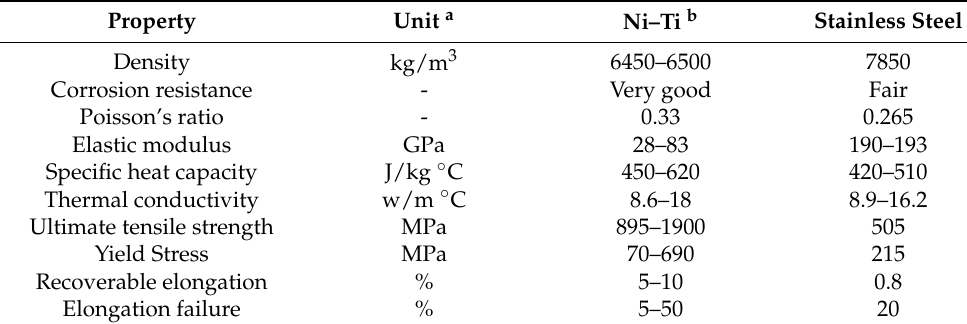
Table 1. Comparison of various properties of Ni–Ti and stainless steel